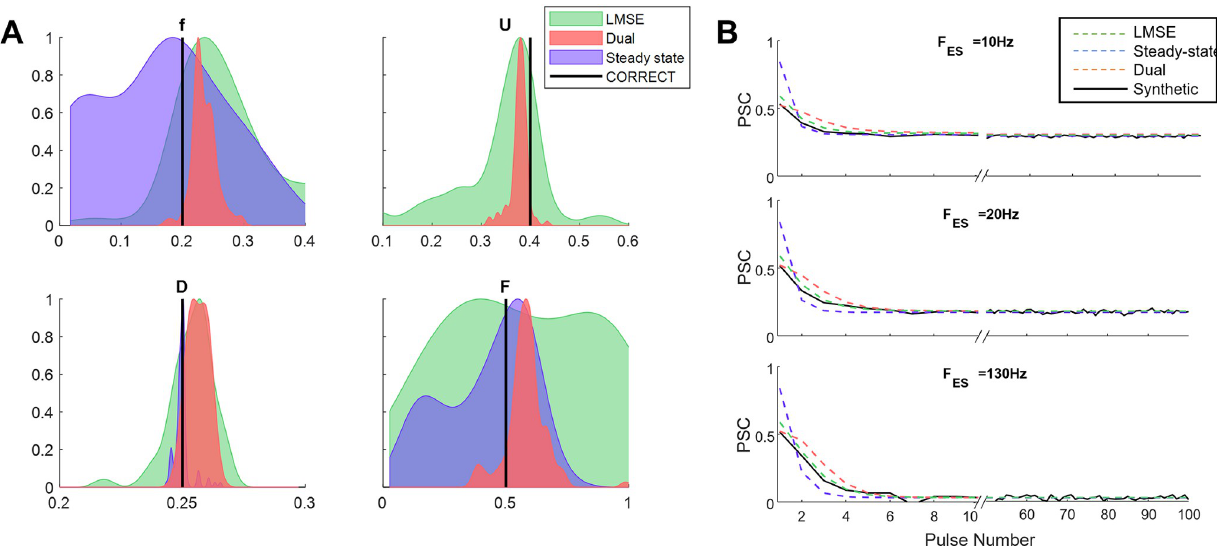
Fig 7. Distribution of estimated parameters by the three approaches with only 3 recorded responses. (A) Normalized PDF of the estimated parameters by the three approaches. The PDFs have been estimated from the results of applying each algorithm with 1000 different initial guesses. Moreover, a 5% white noise has been added to the reference data. The dual optimization approach improved the estimation precision by decreasing the standard deviation of the PDF and moving the mean of the PDFs closer to the true values. (B) The discrete-time TM model output generated by the estimated parameters (in case of having the only the observed frequency) that are obtained from the three methods. The plots include the trace of PSC response for both transient state (from stimulus 0 to 10) and steady-state (last 50